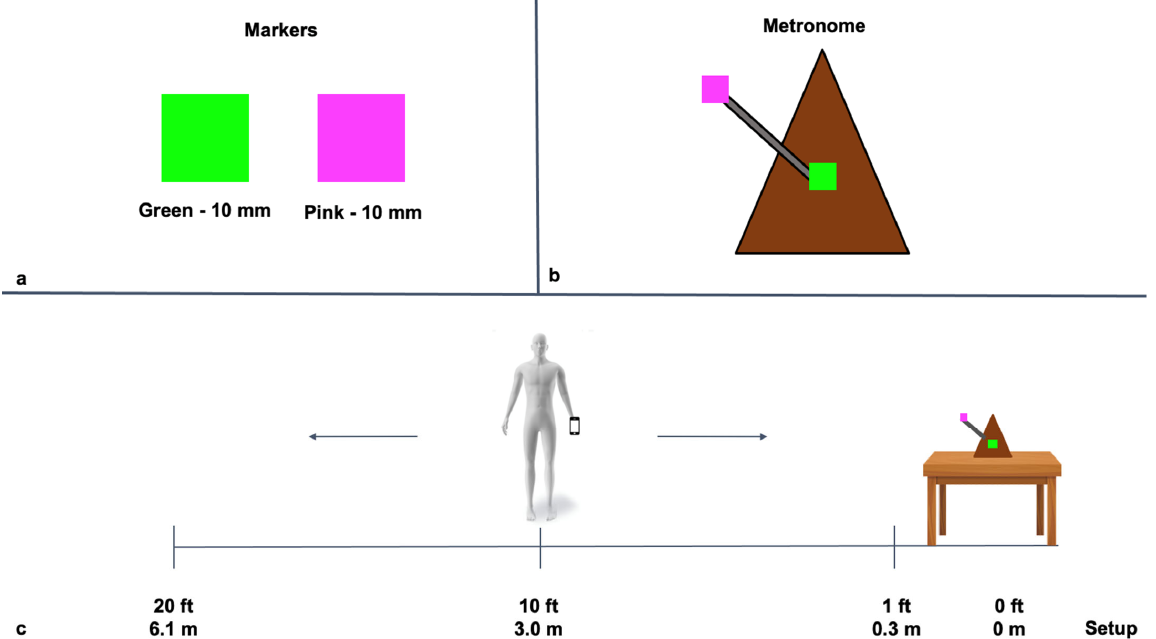
Figure 5. Protocol 3: Configuration for working distance. Neon pink and green markers were cut in 10 × 10 mm size ( a ). Neon pink marker was affixed to metronome at distal end of metronome arm, and neon green marker was affixed to the base of the arm ( b ). Metronome was set at 96 bpm, and videos were captured at 1 ft increments up to 20 ft ( c ).